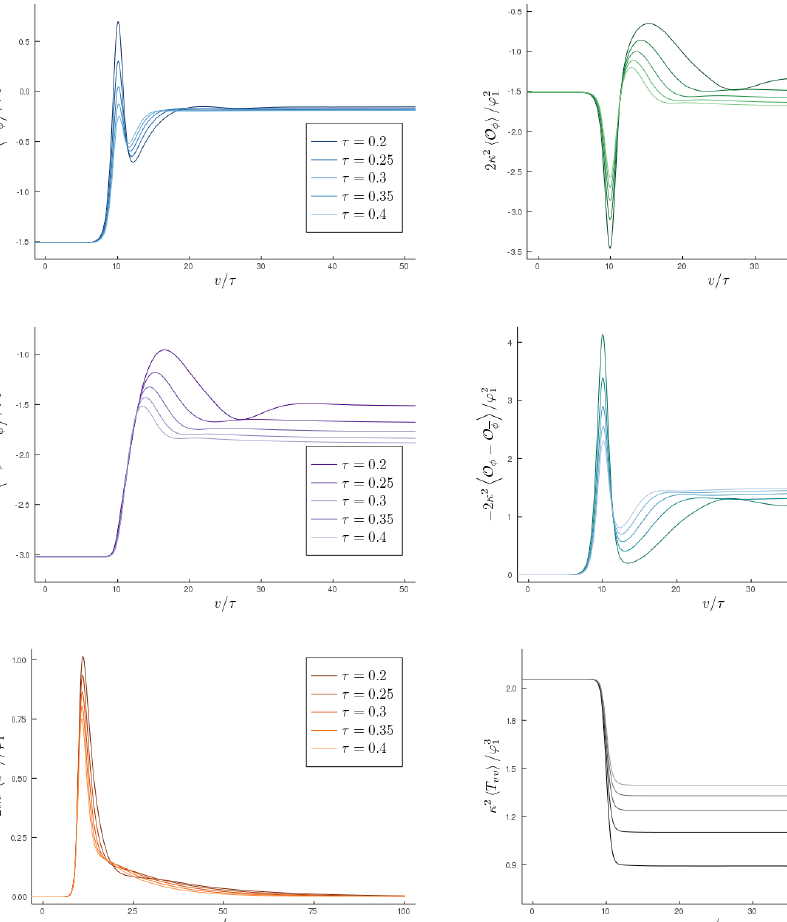
Figure 1: Expectation values 2.22 for a quench with profile 3.1 for several values of τ which interpolates between the Hermitian point ξ = 10 τ We set v m